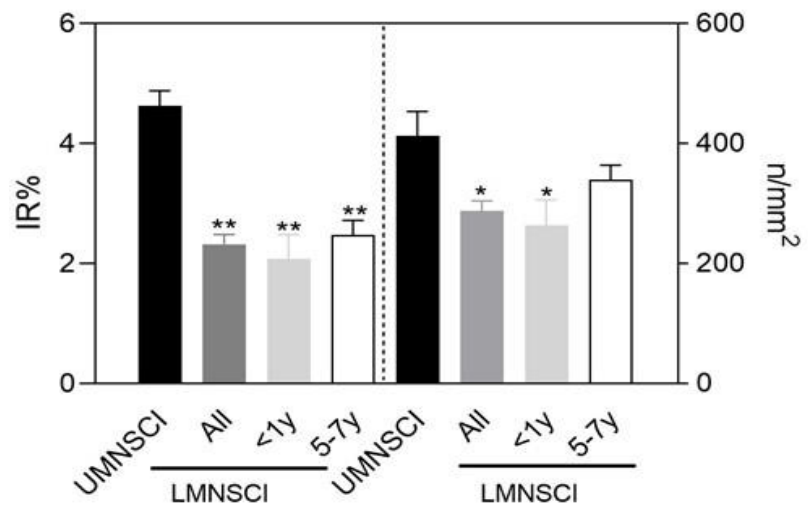
Figure 4. Langerhans cells (CD1a positive) in UMNSCI vs LMNSCI: Quantitation in immunostained epidermal sections of CD1a before + after (Pre + Post) 2 years of NMES on UMNSCI and before (pre) in LMNSCI. IR% is the percentage of immunoreactivity for CD1a; n/mm 2 is the number of LC bodies per square millimeter of epidermis; data are mean ± SEM; statistical significance at p < 0.05 (*) p < 0.0001 (**), unpaired t test.